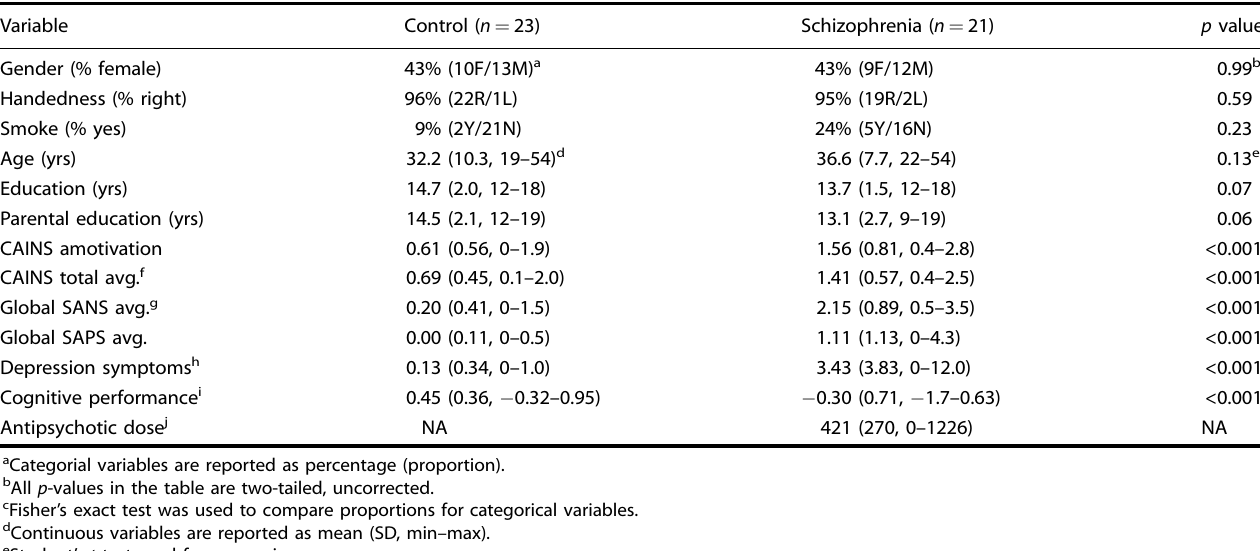
Table 1. Demographic and clinical information for patient and control